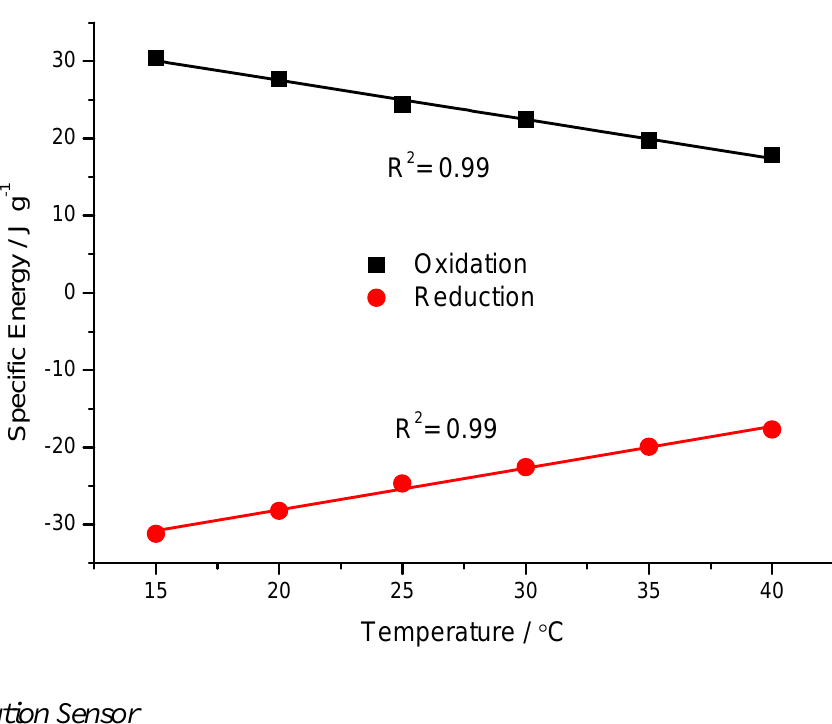
Figure 9. Variation of the electrical energy consumed during oxidation or reduction of a pPy/DBSA film during 60 s in 0.1 M LiClO temperature. R 2 is the correlation coefficient of the linear